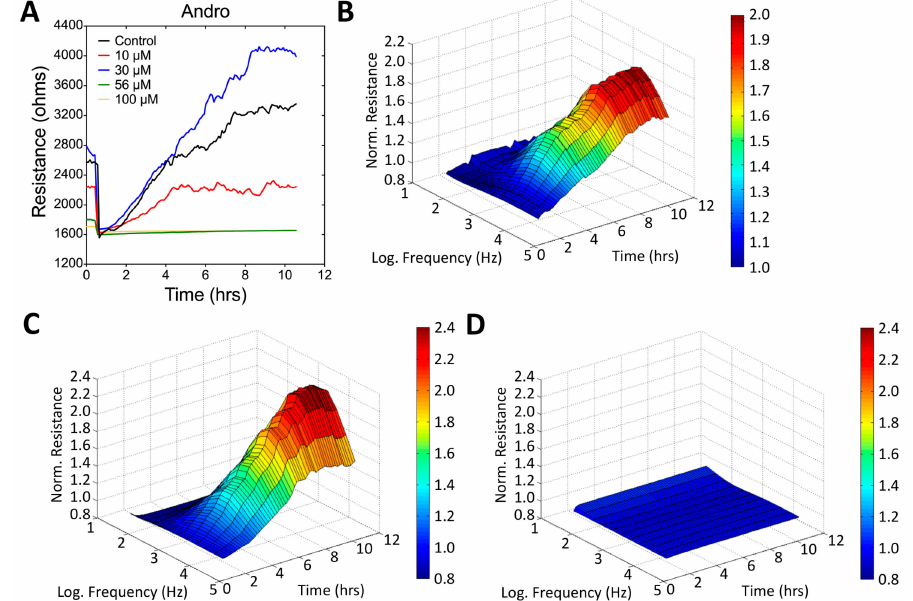
Figure 7. E ff ects of andrographolide on the wound healing and migration of U-87 MG cells measured using ECIS. ( A ) Time course of the measured resistance at 4 kHz; three-dimensional demonstration of the e ff ects of andrographolide at concentrations of ( B ) 0 µ M (control), ( C ) 30 µ M, and ( D ) 100 µ M on cell